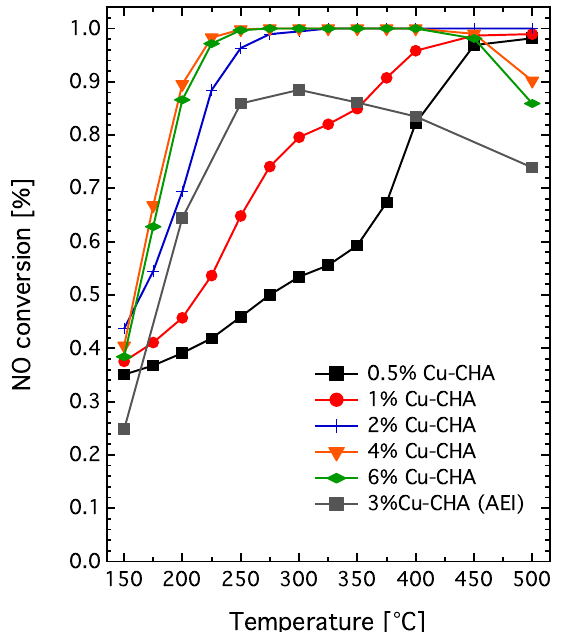
NO conversion profiles during NH 3 -SCR for the Cu-SSZ-13 samples prepared by [NH 3 +NO]-SSIE compared with one Cu-SSZ-13 sample previously prepared using conventional aqueous ion-exchange (AIE) with 3% Cu [10]. The NH 3 -SCR experiments were performed using 400 vol.-ppm NO, 400 vol.-ppm NH 3 , 8 vol.% O 2 , 5 vol.% of water, and Ar as balance. The sample temperature was increased stepwise from 150 to 500 ◦ C with the interval 25–50 ◦ C and kept constant until steady-state was